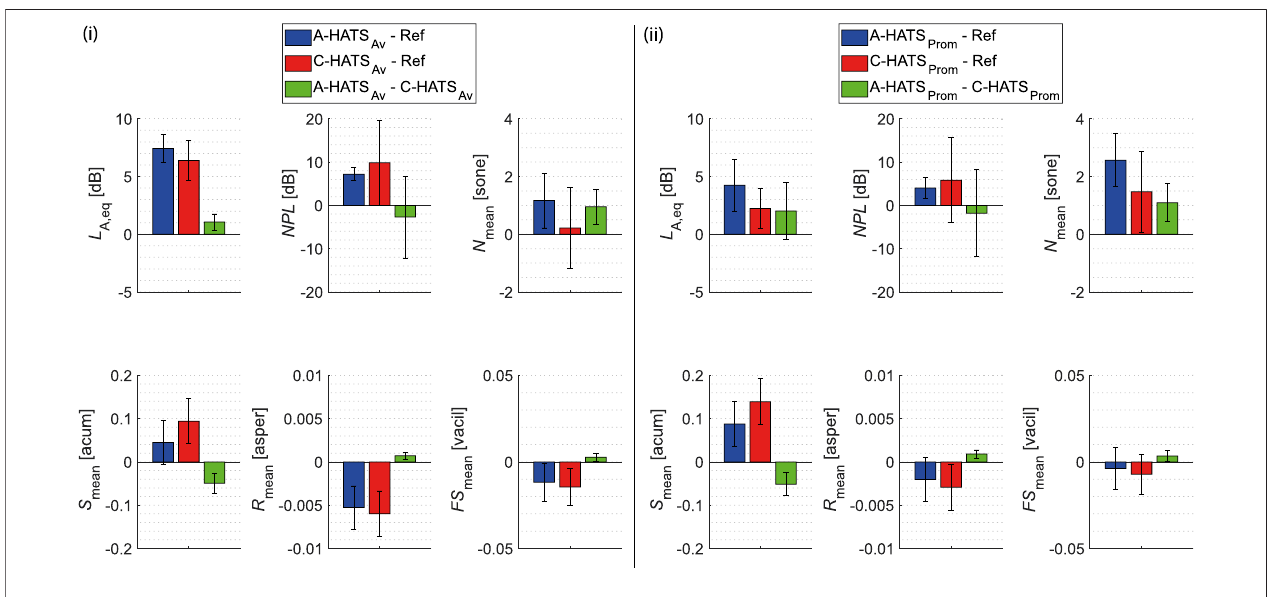
FIGURE 6 | Eachsubplot shows differences inparameter( y -axis)valuesbetweenthreemeasurementmethods. Eachbar representsthe differenceinmean valuesas perthelegendandits95%con fi denceinterval.Twogroupsofdifferencesarepresented:(i)differencesbetweenomnidirectionalmicrophone(Ref),adultandchildHATSwith the averaging method (A-HATS Av /C-HATS Av ) and (ii) differences between Ref, and adult and child HATS with the prominent-ear method (A-HATS Prom /C-HATS Prom ).